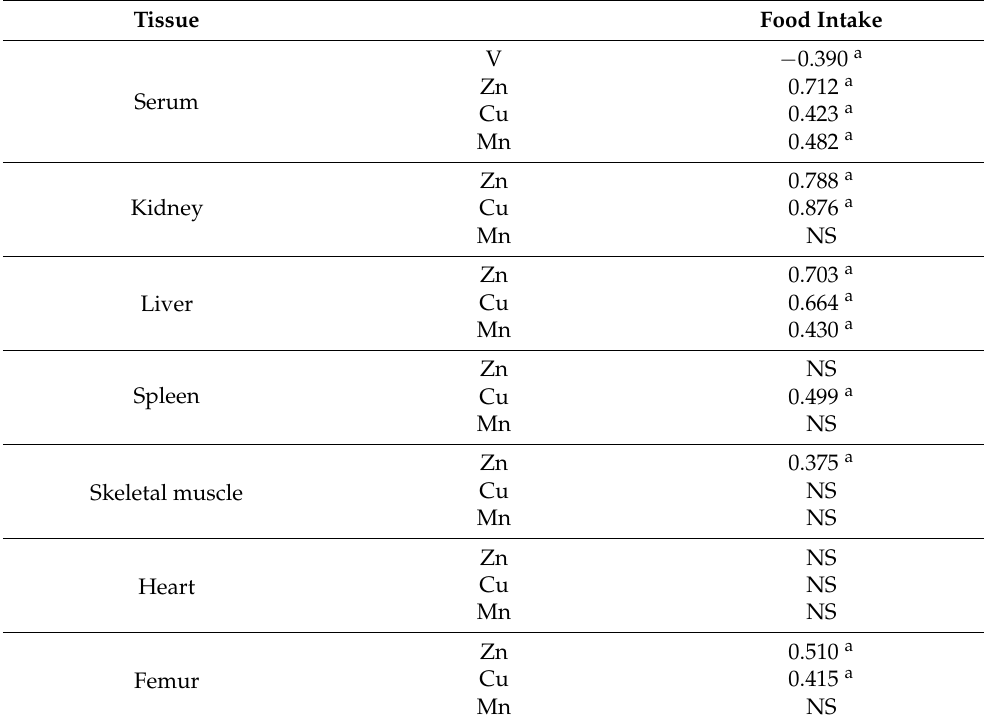
Table 3. Spearman’s rank correlation coefficient between serum levels of V, Zn, Cu and Mn and levels of Zn, Cu and Mn in tissue.